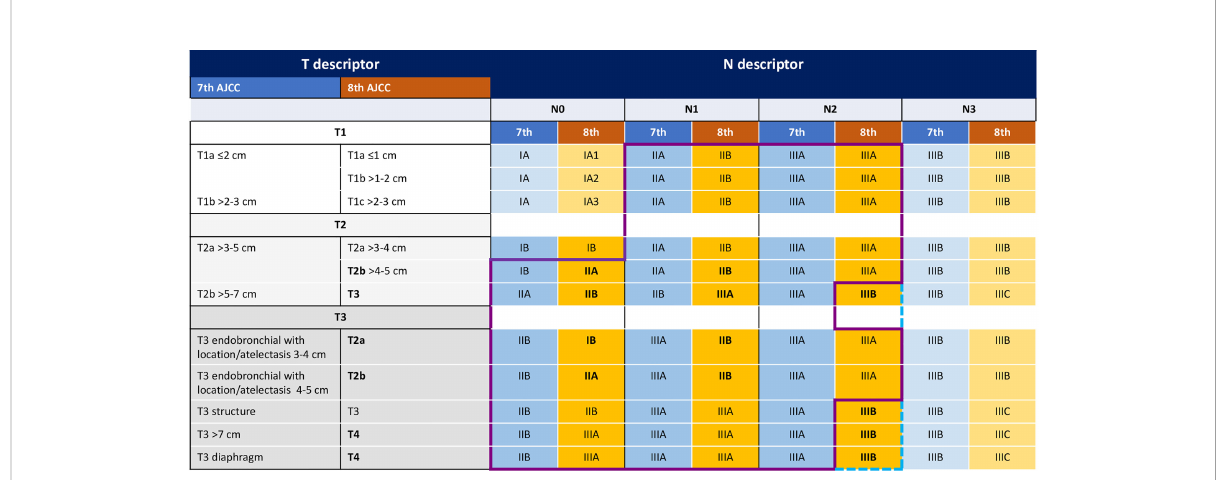
FIGURE 1 The fi gure shows the main changes in TNM categories from the 7 th to the 8 th AJCC TNM edition. Purple line indicates the patients included in the Impower010 trial according to the 7 th TNM, blue line indicates the patients included according to the 8 th